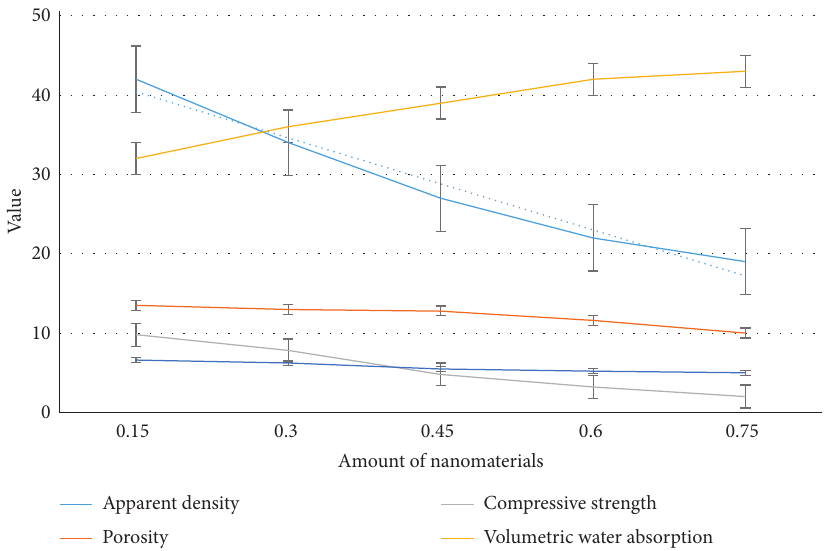
Figure 2: Result analysis diagram of AOS parameter powder amount of nanomaterials.